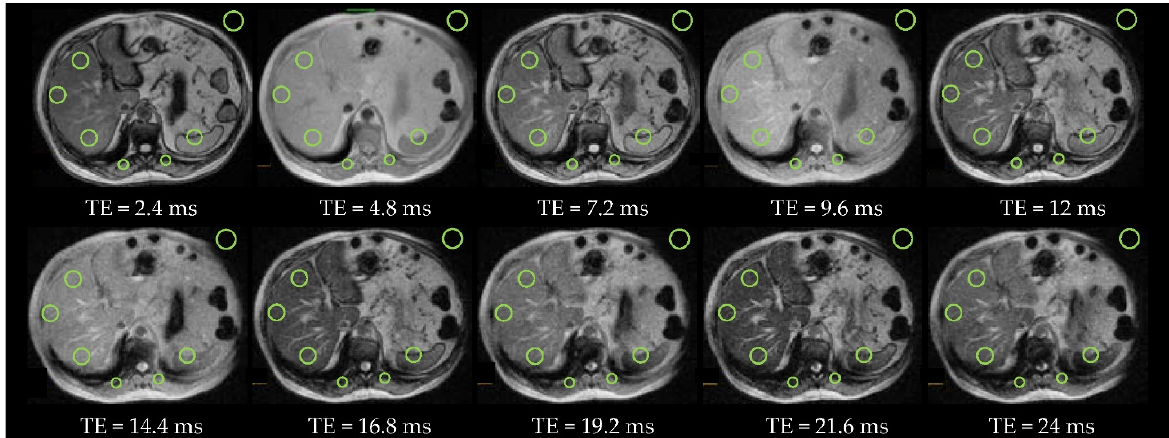
Figure 7. Patient #6 with absence of iron overload and severe steatosis at 1.5T ( T2 * = 17.5 ms and LIC = 34 µmol/g). There are 10 echoes with a duration of 2.4 ms each echo. The OOP images are with TE = 2.4 ms, 7.2 ms, 12 ms, 16.8 ms, and 21.6 ms and IP images are with TE = 4.8 ms, 9.6 ms, 14.4 ms, 19.2 ms, and 24 ms. There are 3 ROis in the liver, 2 ROIs in paravertebral muscles, 1 ROI in the spleen and 1 ROI of background noise.